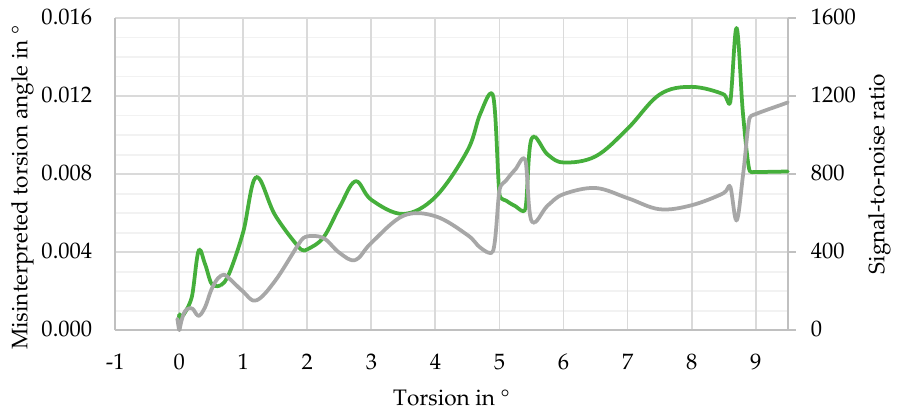
Figure 17. Possible misinterpretation of a temperature change of +10 K as torsion, relative approach. Green: angle in ° (left axis), grey: signal-to-noise ratio (right axis).